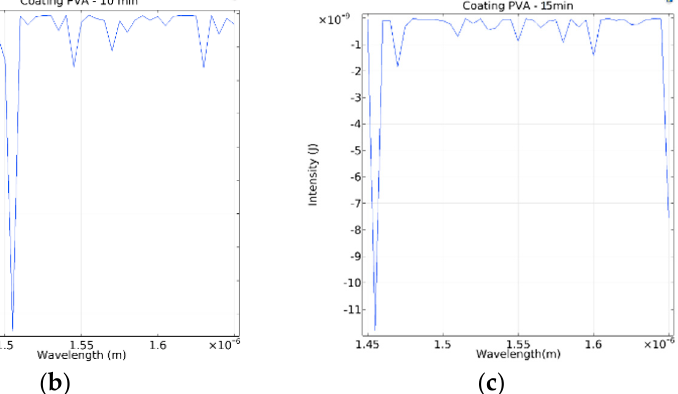
Figure 7. Sensor spectrum simulated in COMSOL for sensors with electrospinning durations of ( a ) 5 min, ( b ) 10 min, and ( c ) 15 min.